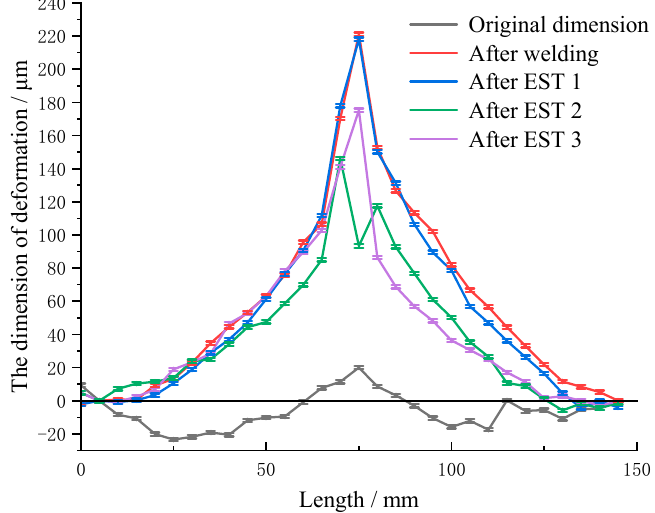
Figure 11. Levelness changes at the bottom of the C-pillar.